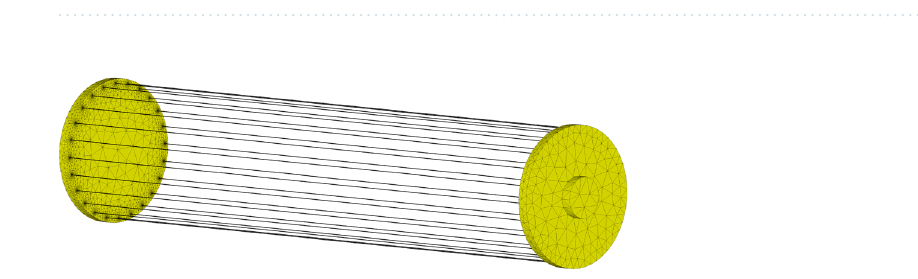
Figure 7. Schematic drawing of the electro-explosive striated disintegration process of the fusible element under the conditions of a significant current density steepness.